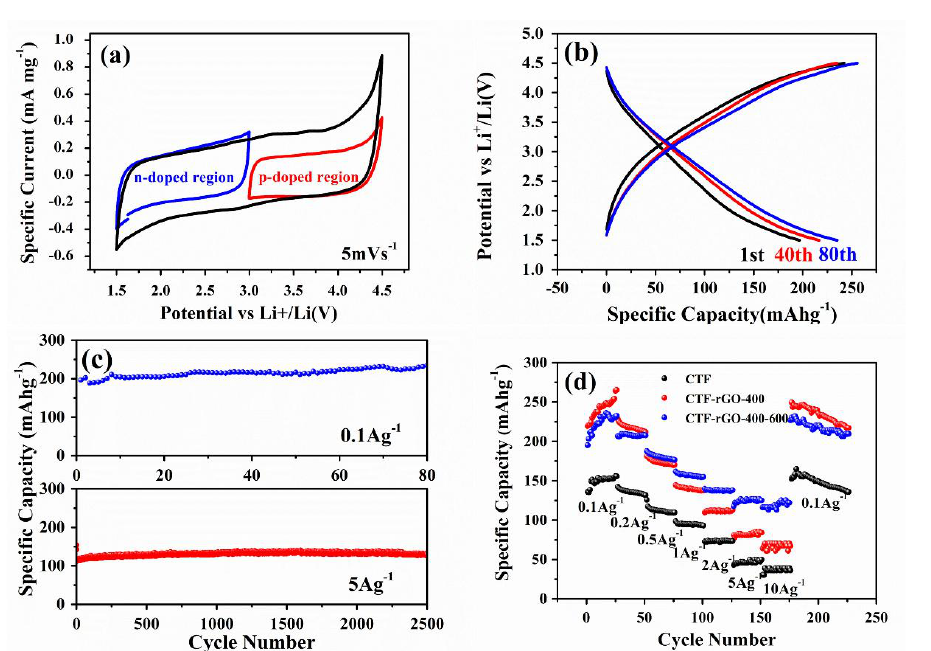
Figure 4. Electrochemical property tests of the CTF, CTF-rGO-400, and CTF-rGO-400-600. ( a ) CV measurement of CTF-rGO-400-600 scanned at 0.1 mV/s; ( b ) Galvanostatic charge – discharge curves of CTF-rGO-400-600 at various cycles measured at 0.1 A/g; ( c ) cycling stability test of CTF-rGO-400-600 at 0.1 A/g and at 5 A/g up to 2500 cycles; ( d ) rate performance comparison between the three samples at various current densities.